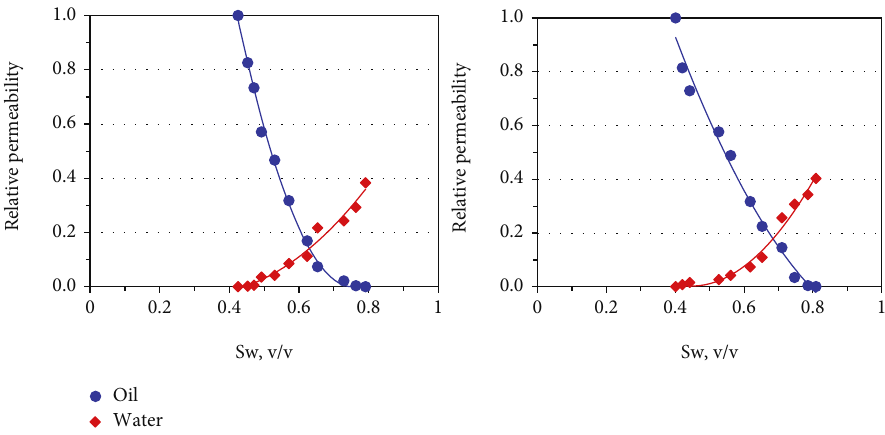
Figure 7: Relative permeability curves of samples T2 and T3.